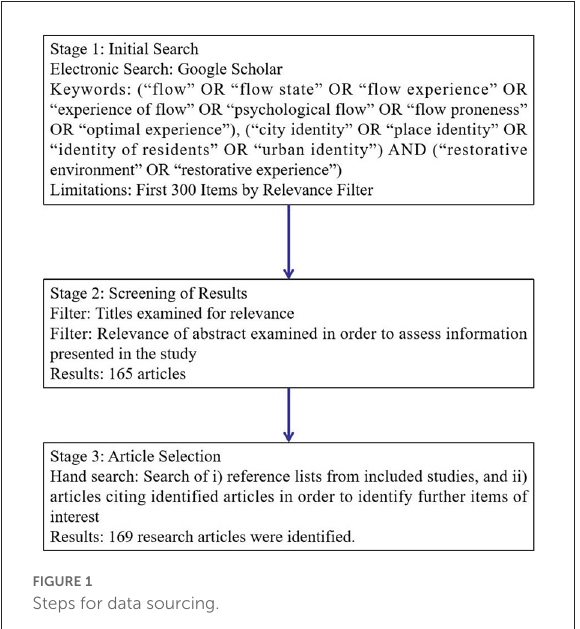
FIGURE1 Steps for data